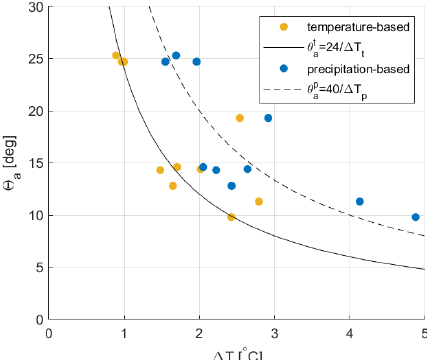
Figure 12. The cut-off AOD angle θ a at different levels of cool- ing (cid:49)T estimated using temperature responses and precipitation re-